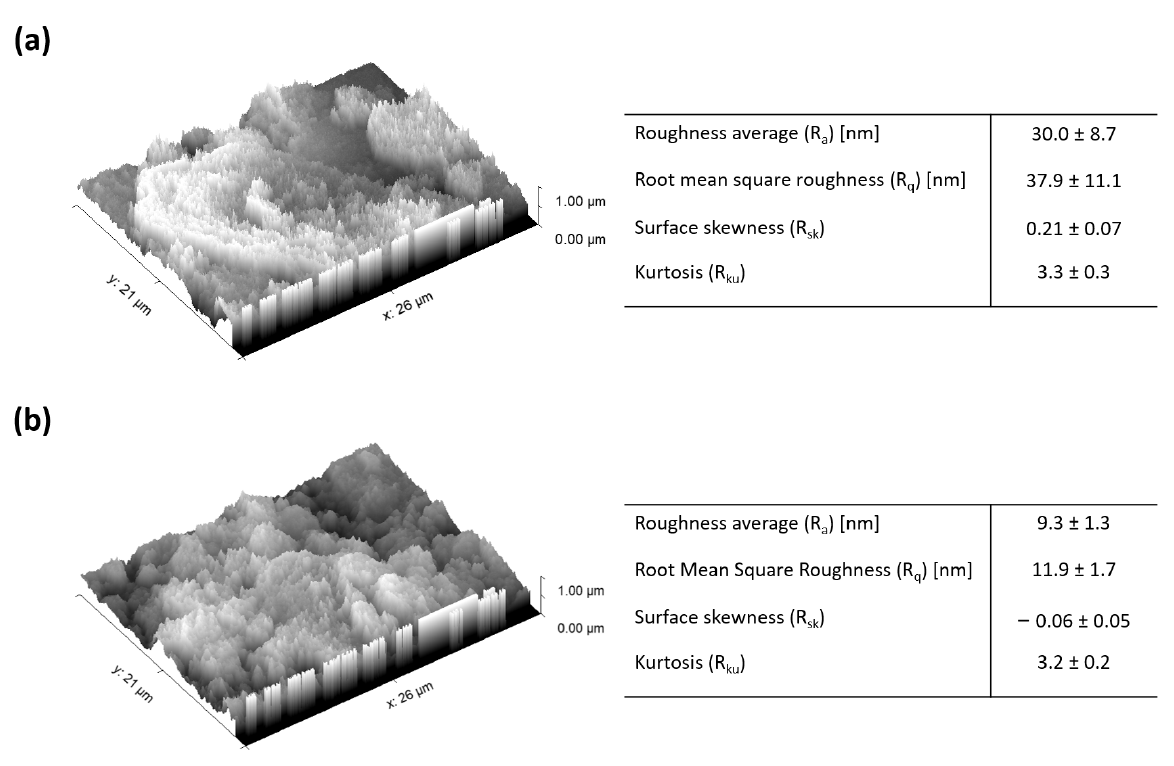
Figure 9. 3-D SEM images and surface roughness parameters of ZnO NPs before ( a ) and after ( b ) Cu(II) adsorption. The 3-D SEM images and surface roughness parameters ( R a , R q , R sk and R ku ) were obtained by the Gwyddion software.